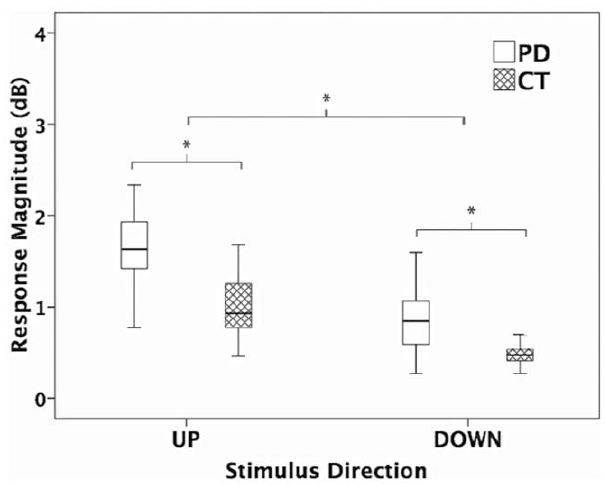
Figure 4. Box plots illustrating the voice loudness response magnitudes as a function of stimulus direction and testing group. Box definitions: middle line is median, top and bottom of boxes are 75th and 25th percentiles. Cross-hatched boxes and blank boxes represent the responses for the control group and the PD group, respectively. The asterisks indicate significant differences between conditions.